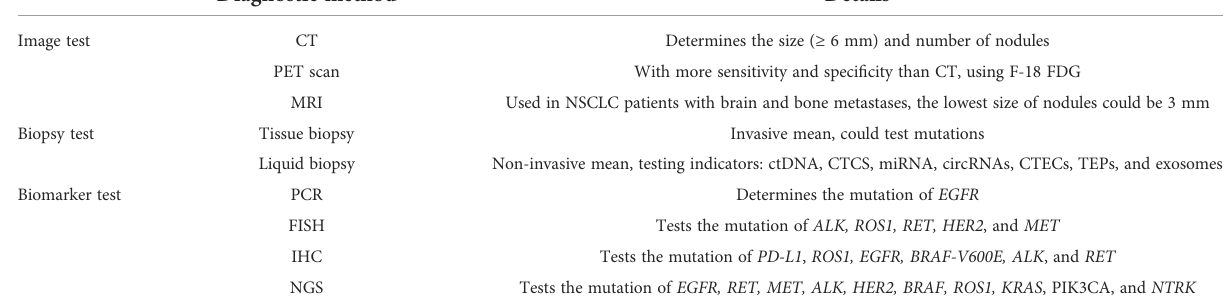
TABLE 1 Diagnostic methods in lung